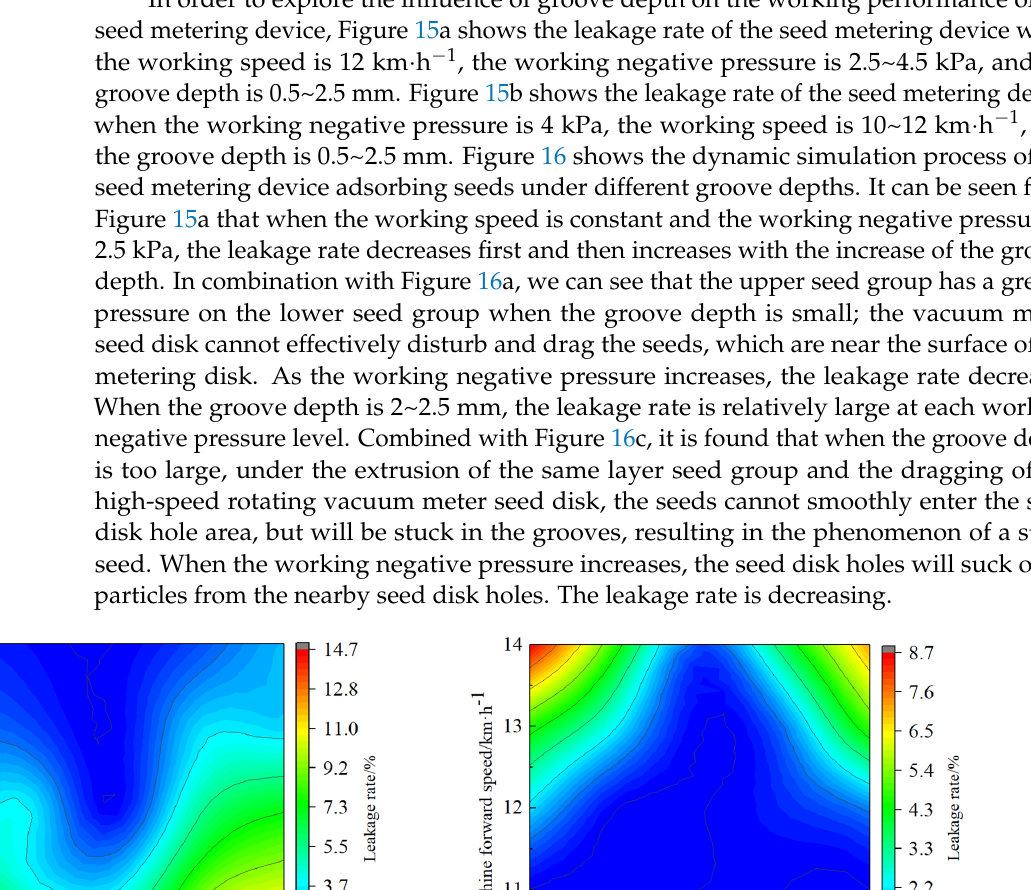
( c ) Figure 16 . Dynamic simulation process of the seed metering device sucking seeds under different groove depths. ( a ) 0.5 mm, ( b ) 1.5 mm, ( c ) 2.5 mm. Note: The black circle represents the sucked multiple seeds, and the green circle represents stuck seeds. It can seen from Figure 16b that with the working negative pressure is 4 kPa as a fixed factor, when the forward speed of the machine is less than 12 km·h − 1 , the leakage rate of the seed metering device is all lower. When the groove depth is 0.5~1 mm and 2~2.5 mm, with the increase of the forward speed of the machine, the leakage rate increases. To sum up, it can be seen the groove depth should be chosen as 1.5 mm. 4.3. Influence of Groove Depth on Picking Up Time To further analyze the working influence of groove depth on the performance of the seed metering device, as shown in Figure 17, when the working speed is 12 km·h − 1 , the average pinking up time of seeds is plotted under different working negative pressures and groove depths. It can be observed that when the groove depth is a certain value, and the working negative pressure is small, the seed picking-up time is long, as when the working negative pressure increases, the seed picking-up time is short. When the groove depth increases sequentially within 0.5~1.5 mm, the picking-up time is gradually short- ened under each negative working negative pressure level. When the groove depth in- creases sequentially within 1.5~2.5 mm under each working negative pressure level, the